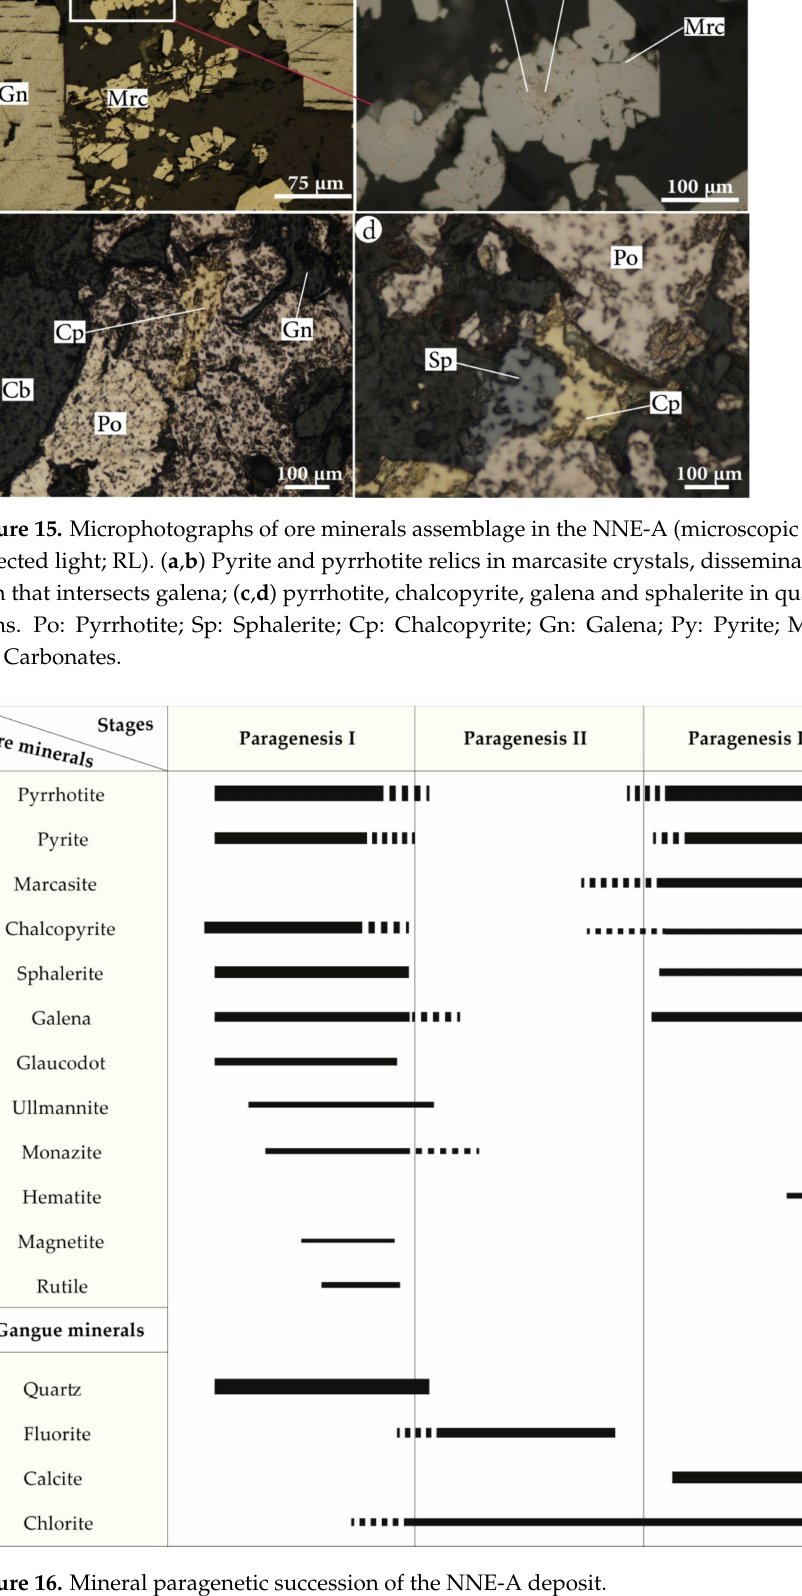
Figure 16. Mineral paragenetic succession of the NNE-A